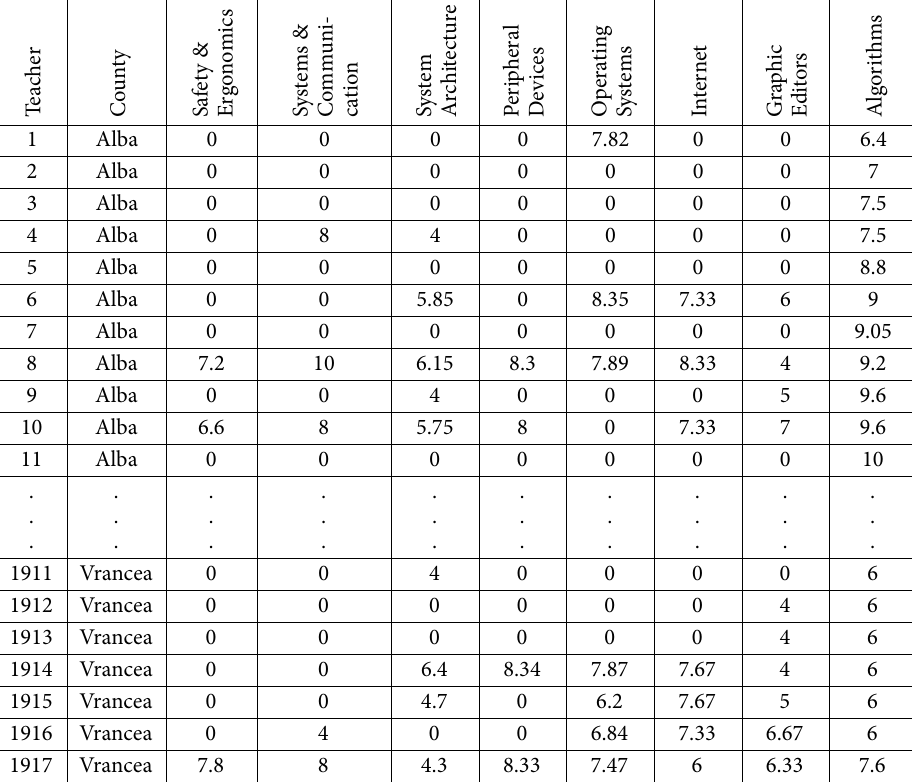
Table 2. Teachers evaluated portfolios based on the domains they created content for